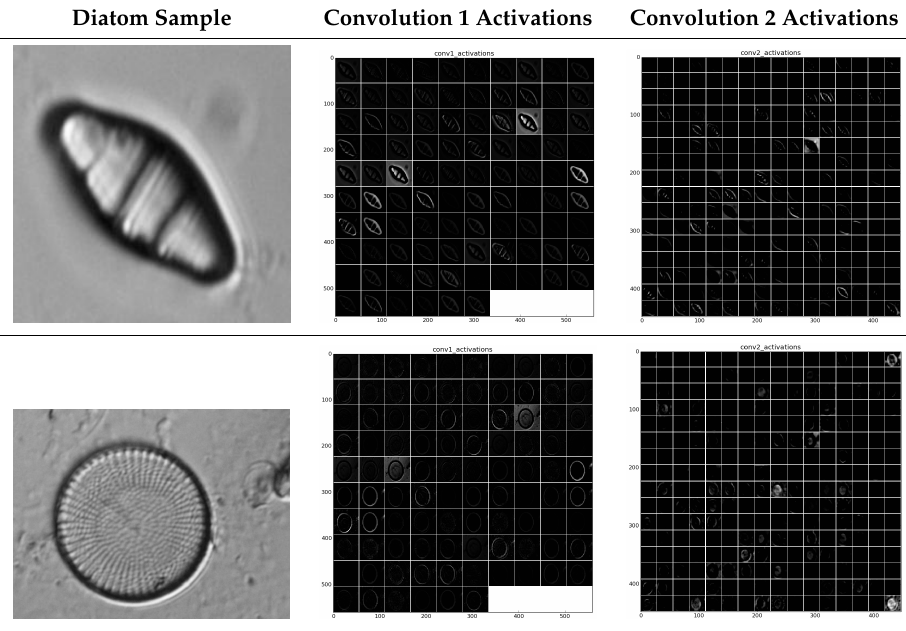
Table 9. Examples of activations in the first two convolution layers in neural network. Each row shows an example of the classified diatom and the corresponding